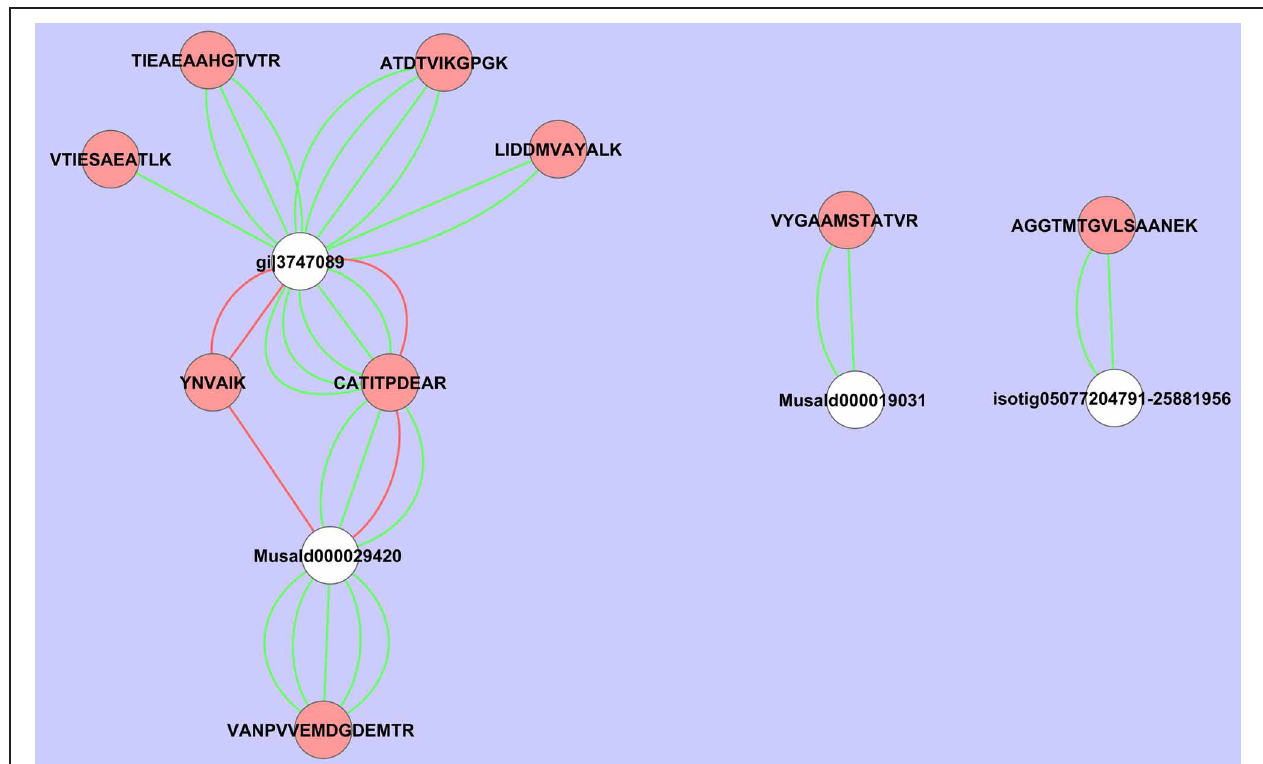
FIGURE 5 | Cytoscape representation of spot 32. Redundancy in M/Z values was removed and only the peptide with the highest ion score/proteins score was retained. Interactions with an ion score ≥ 40 are displayed in green, < 40 in red. Proteins are represented by white ellipses and peptides by red